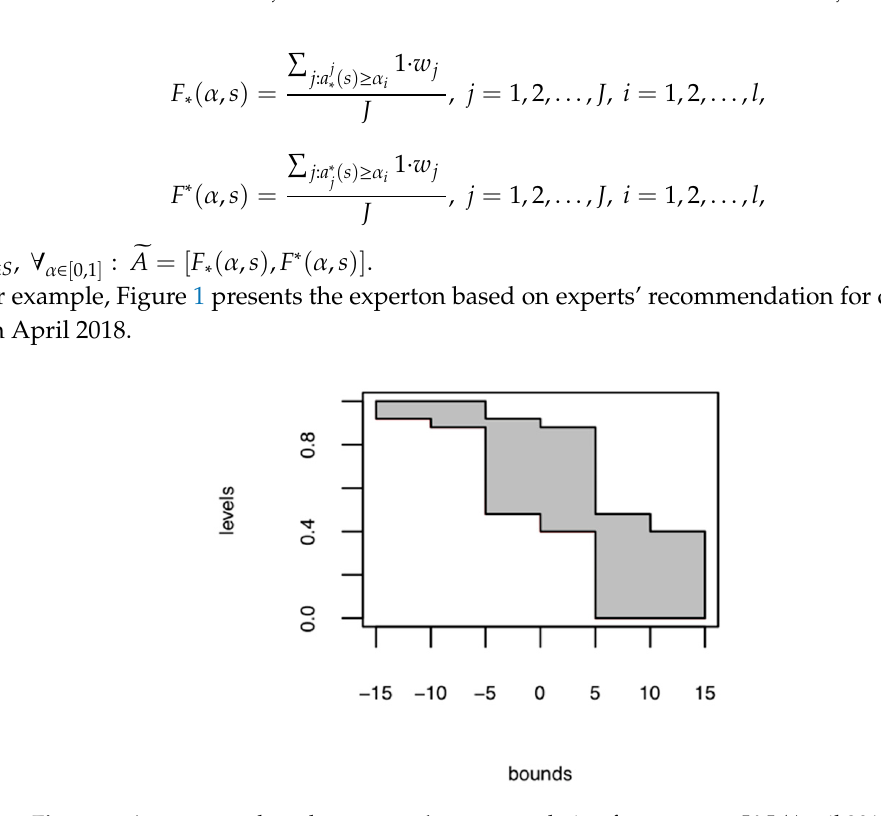
Figure 1. An experton based on experts’ recommendation for company J&J (April 2018).